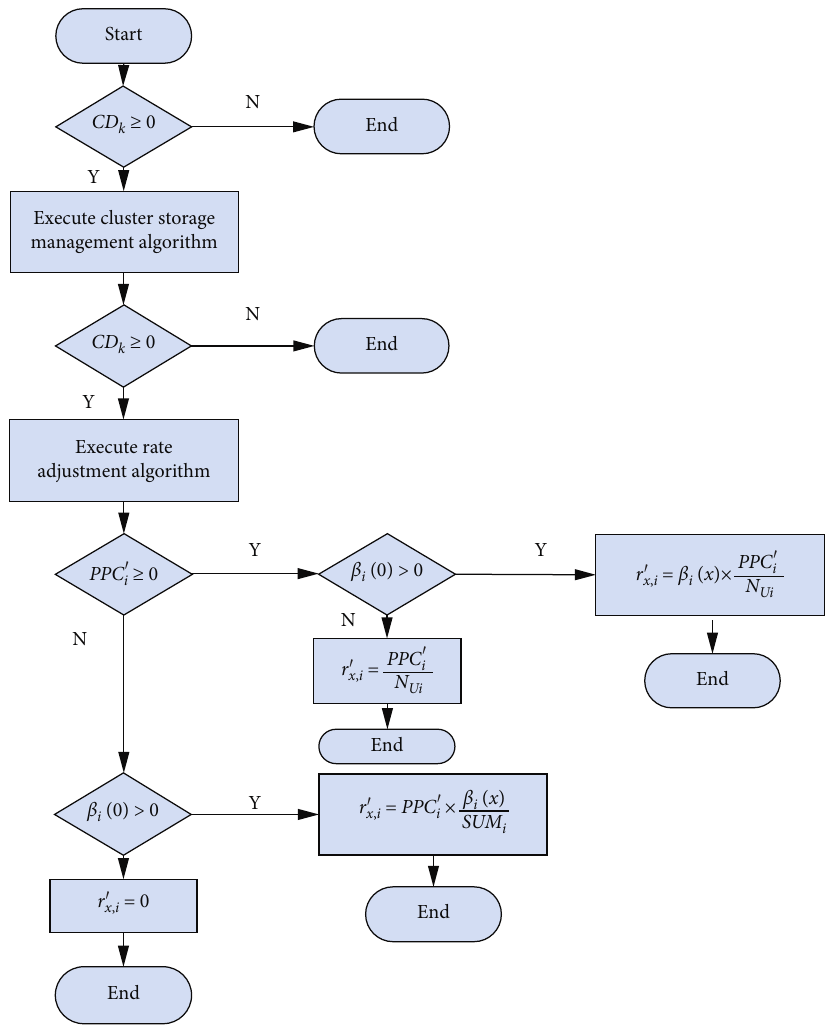
Figure 2: Process flow chart of the OFMNSE